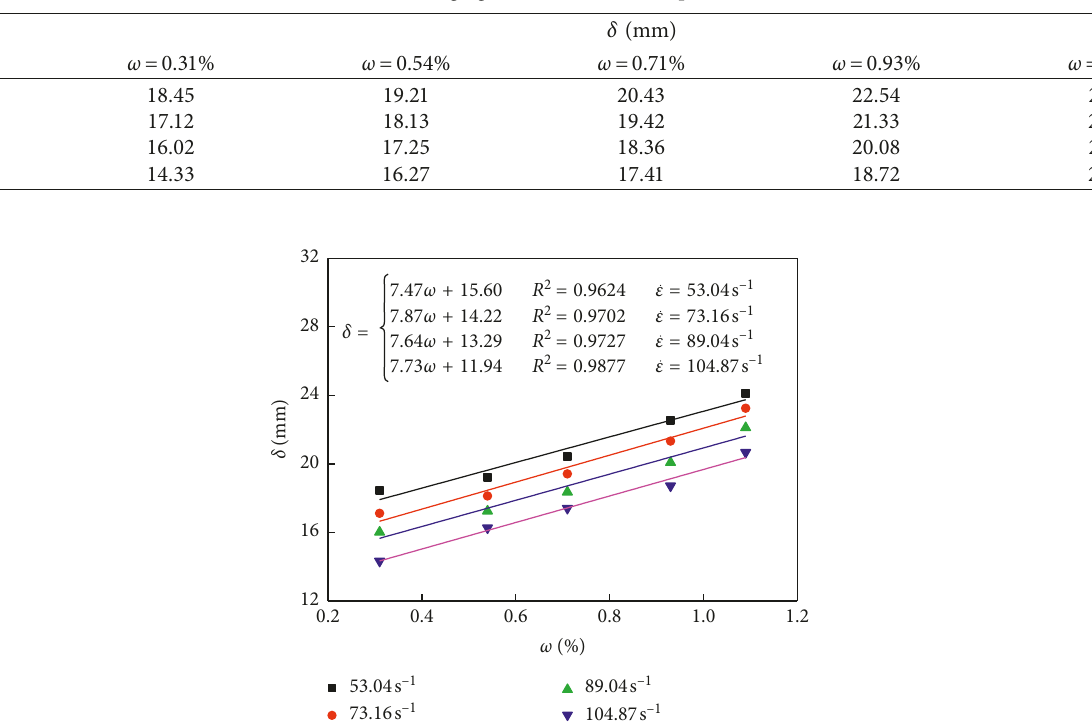
Table 4: Average grain sizes of all the specimens.